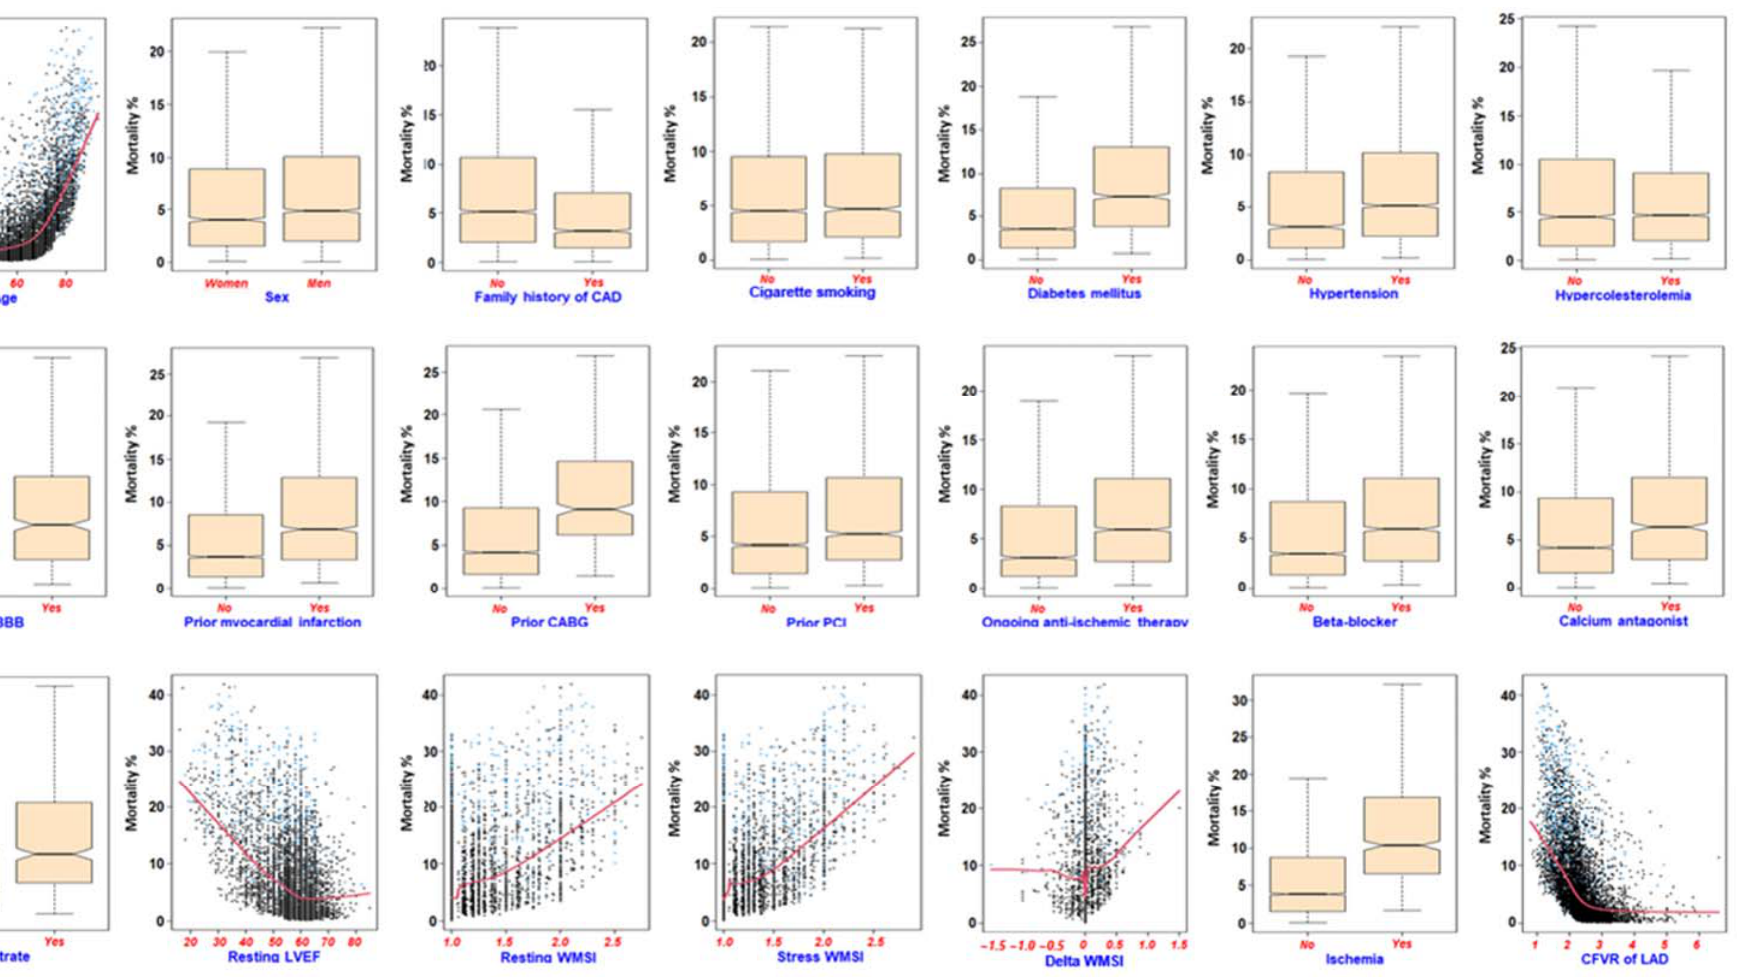
Figure 3. Variable dependence plot. Individual case predictions are marked with points. A less smooth curve indicates the trend as the variables increase with a shaded 95% confidence band. The mean of the minimal depth distribution is used as the threshold value for deciding whether a variable’s minimal depth value is small enough for the variable to be classified as strongPoints in blue correspond to events, black points are censored observations.